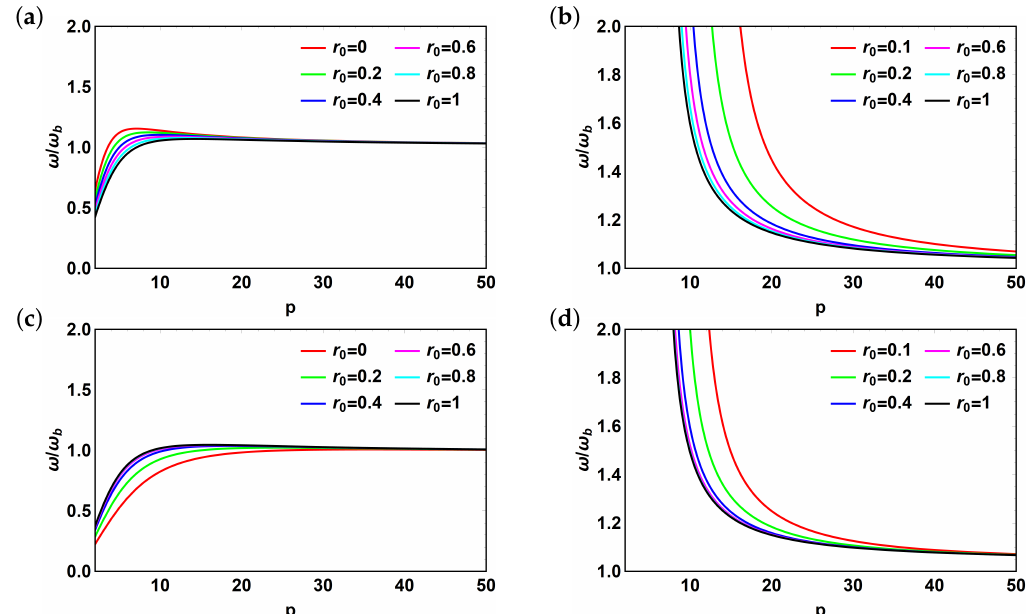
Figure 10. Normalized frequency as a function of p (distance between bubble centers) for metascreen ( a ) w/1 interface and w/reflector, “positive” branch, kh (cid:28) 1, δ (cid:28) 1; ( b ) w/1 interface and w/reflector, “negative” branch, kh (cid:28) 1, δ (cid:28) 1; ( c ) w/1 interface and w/reflector, “positive” branch, kh (cid:28) 1; ( d ) w/1 interface and w/reflector, “negative” branch, kh (cid:28) 1. For all plots q =